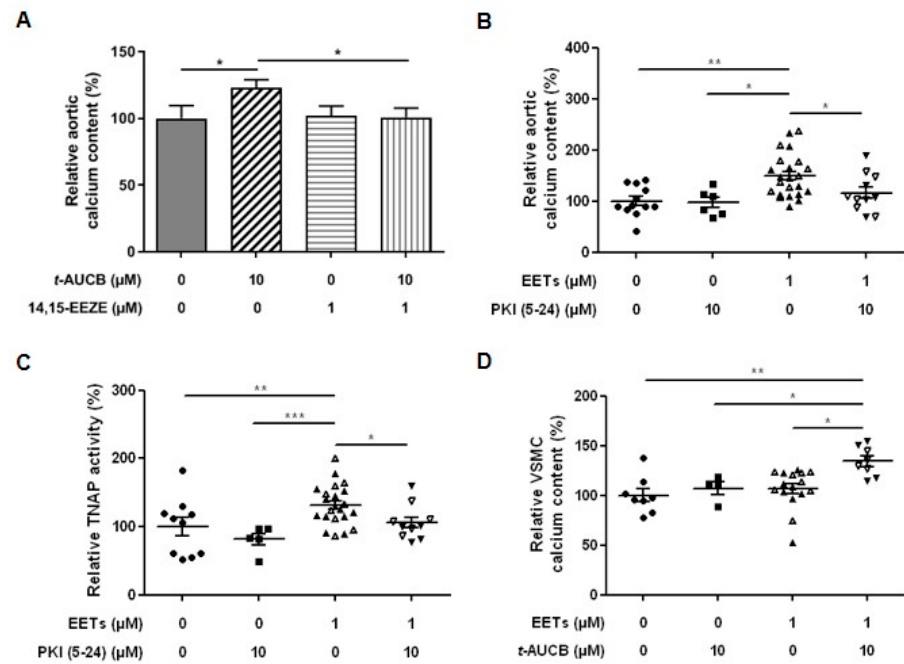
Figure 5. Relative aortic calcium content after 7 days of culture in high-phosphate conditions (3.8 mM inorganic phosphate, Pi) in the absence and in the presence of 10 µM t -AUCB and the EET antagonist 14,15-epoxyeicosa-5(Z)-enoic acid (14,15-EEZE) at 1 µM (( A ) n = 6 per group). Relative aortic calcium content ( B ) and tissue-nonspecific alkaline phosphatase (TNAP) activity ( C ) in culture